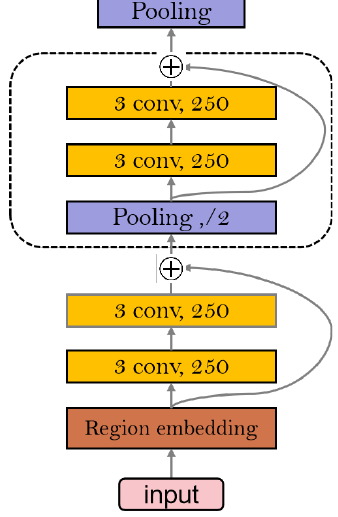
Figure 3. DPCNN model structure.